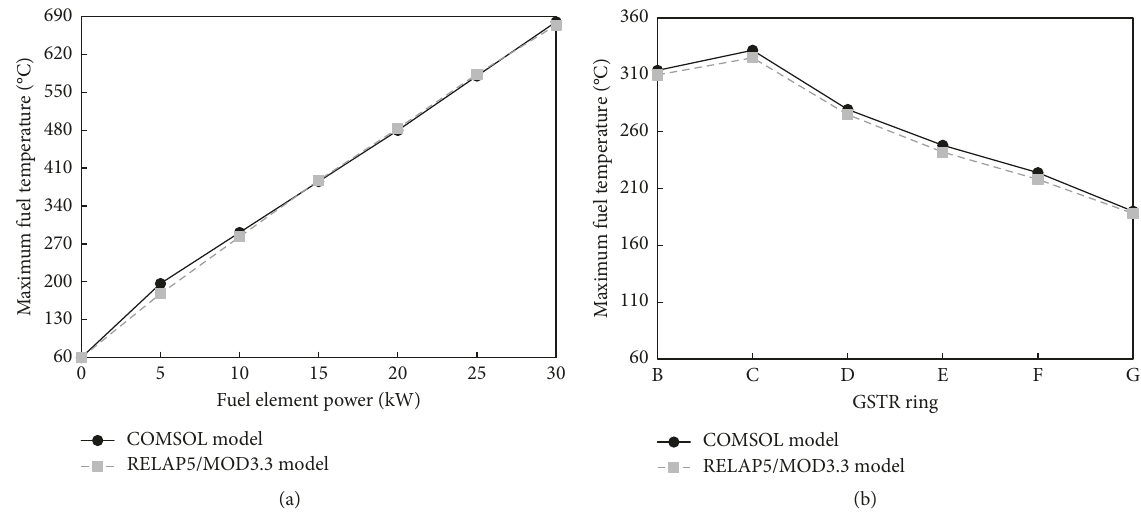
Figure 12: Calculated maximum fuel temperatures in the fuel elements with stainless steel cladding versus the (a) fuel element power and (b) GSTR ring.